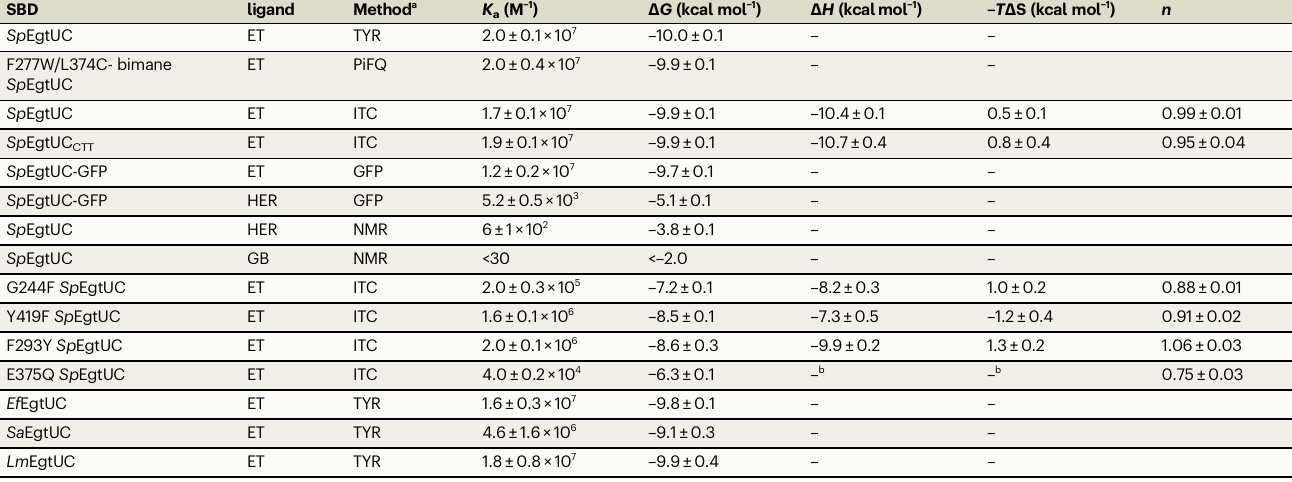
Table 1 | Summary of parameters obtained for the binding of ET and other ligands to wild-type and mutant Sp EgtUC SBD